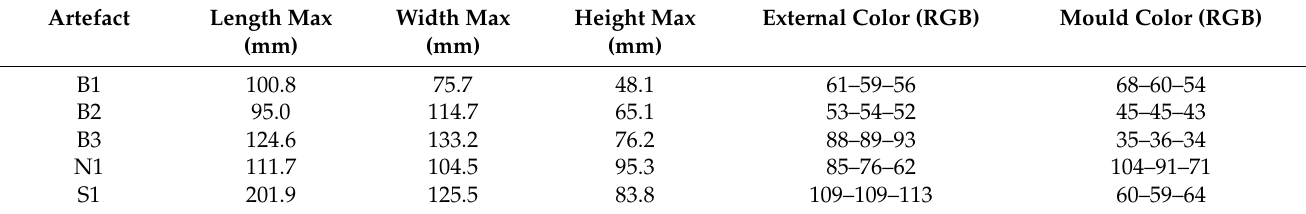
Table 1. Dimensional characteristics and color (mean RGB values) of the archaeological finds studied. Artefact Length